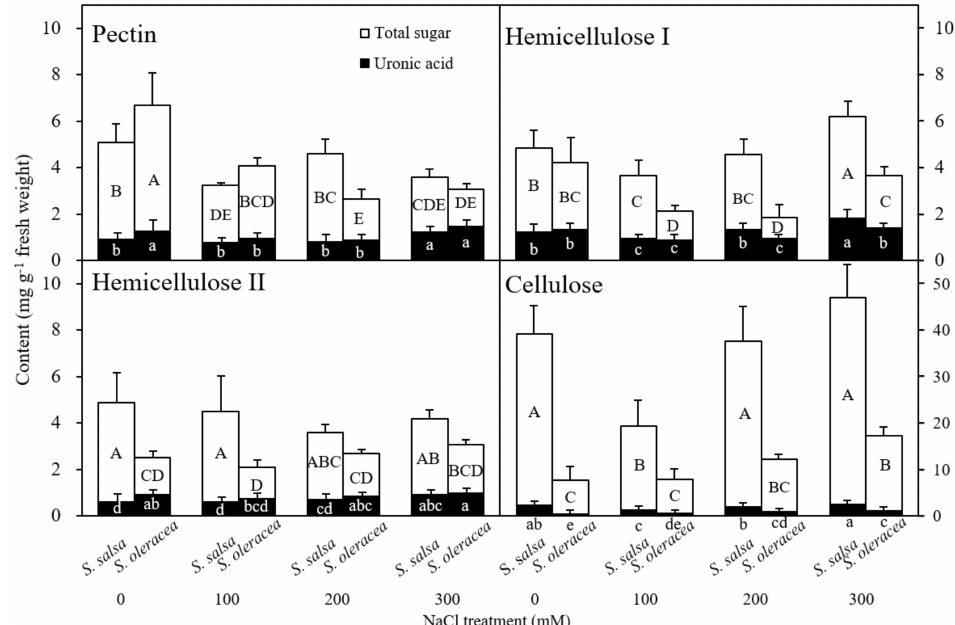
Figure 6. Total uronic-acid-containing sugar and uronic acid content in the pectin, hemicellulose I, hemicellulose II, and cellulose cell wall fractions in the apical 5–10 mm region in S. salsa and S. oleracea roots grown under 0, 100, 200, and 300 mM NaCl treatments. Data are mean + S.D. ( n = 4). Different uppercase (total sugar) and lowercase (uronic acid) letters indicate significant differences ( p < 0.05). Table 2. Cross-correlation coefficients of final root length (RL); total sugar content of pectin, hemi- cellulose I (HC-I), hemicellulose II (HC-II), and cellulose; uronic acid (UA) content of pectin, HC-I, HC-II, and cellulose in the 0–5 mm region of apical root cap in S. salsa . RL Pectin HC-I HC-II Cellulose